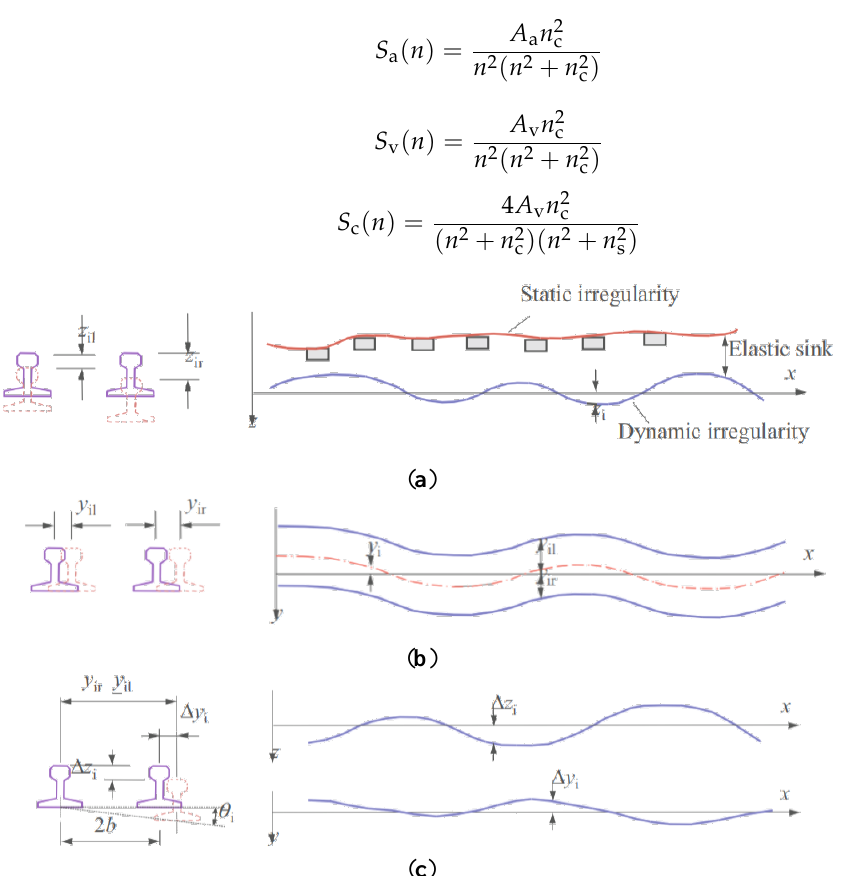
Figure 3. Illustrations of track irregularities: ( a ) vertical profile; ( b ) alignment; ( c ) cross-level. Table 3. Parameters of the train operation. Items Values